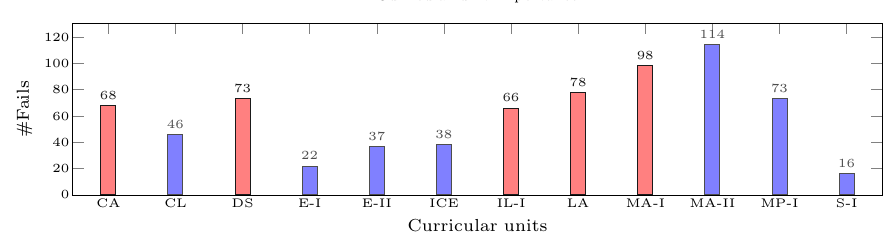
Figure 5. Number of fails per curricular unit (feature red: used in the model, feature blue: discarded).